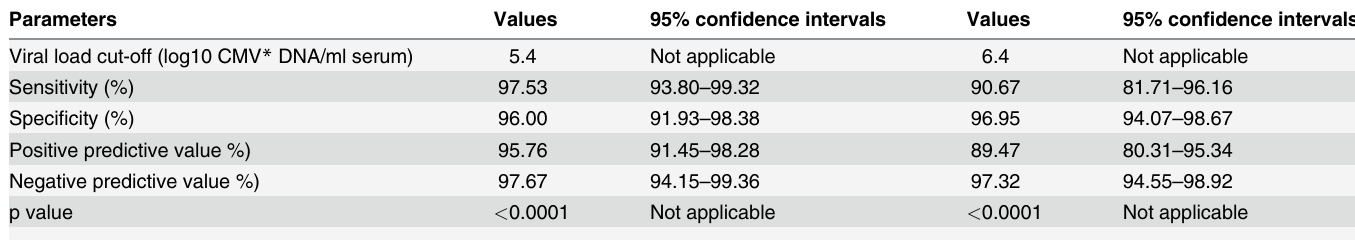
Table 4. Sensitivity, speci fi city, positive and negative predictive values for the CMV viral load cutoffs associated with development and dissemination of CMV associated EODs.